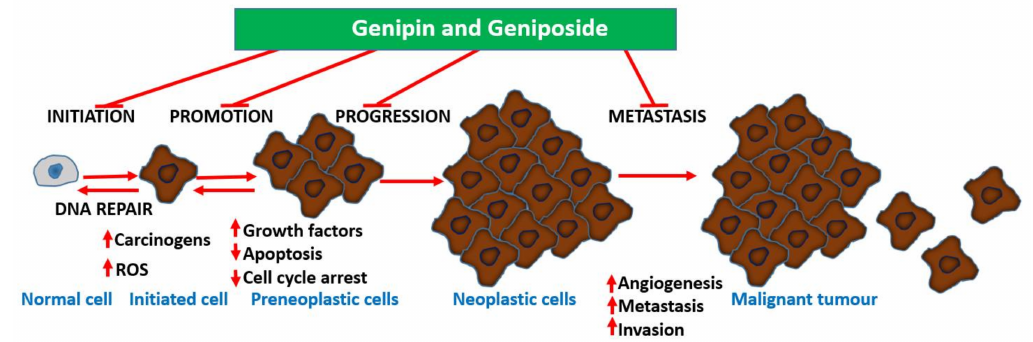
Figure 3. The various stages of cancer development and their potential modulation by genipin and analogs. Genipin/geniposide appear to target almost all stages of cancer development via multiple